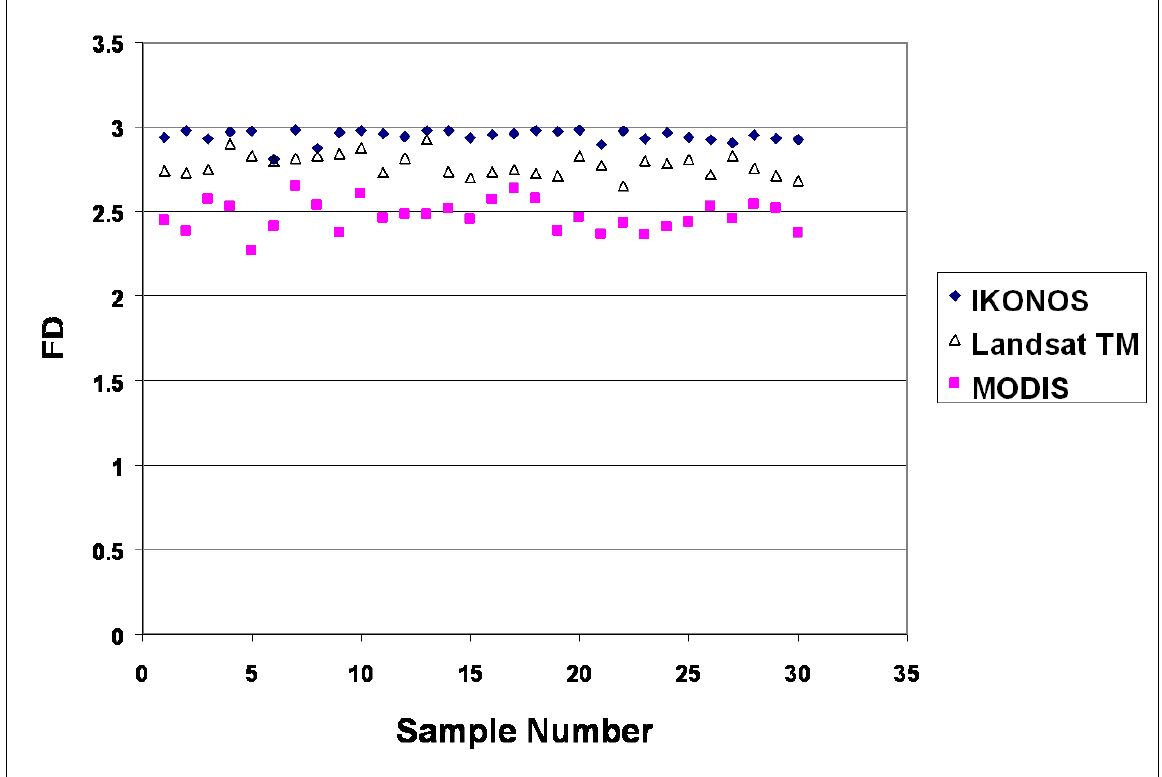
Figure 6. Fractal dimension results of Guatemala study area for different spatial resolution data